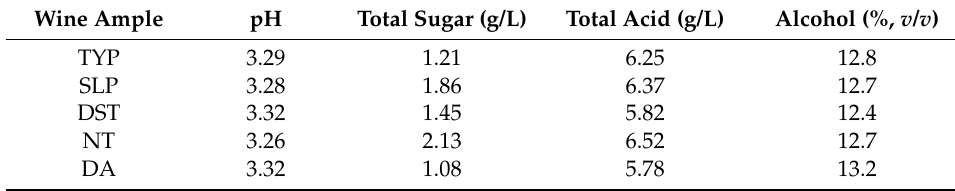
Figure 3. The different terrain features of five vineyards in the Chinese Loess Plateau region. Table 4. Basic information on the five different Loess Plateau region wines.